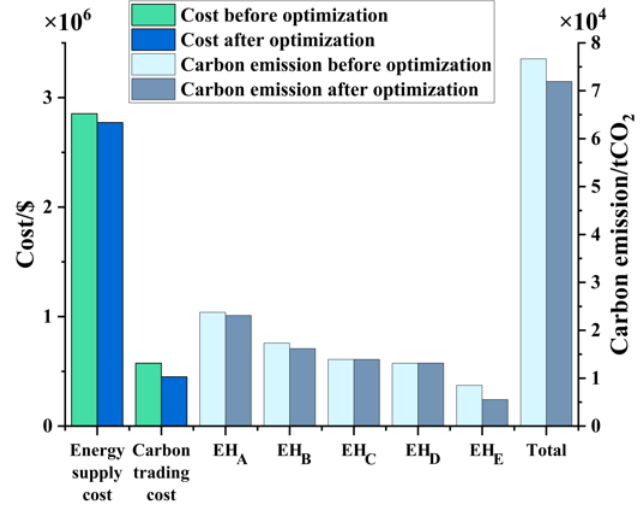
Figure 8. The total power/gas demand before and after the optimization in Scenario 1.